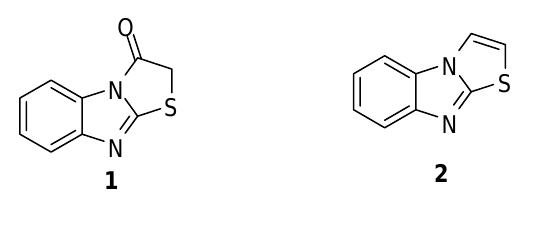
Figure 1. Structure of compounds 1 and 2